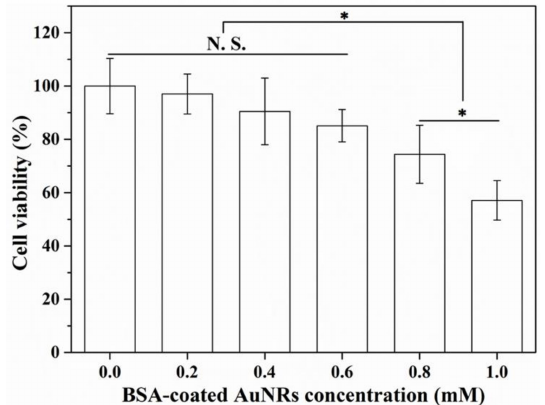
Figure 4. Cell viability of 4T1-Luc cells incubated in medium containing BSA-coated AuNRs at different Au concentrations (0.0 mM, 0.2 mM, 0.4 mM, 0.6 mM, 0.8 mM and 1.0 mM) for 1 day. Data are presented as mean ± standard deviation, n = 3. No significant difference: N.S.; significant difference: * p < 0.05.